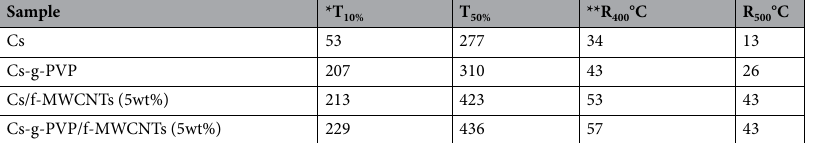
Table 1. Thermal properties of various investigated samples. *T = The temperatures at which the material lost 10% and 50% of their weight, **R = The residual weights of the tested samples at 400 °C and 500